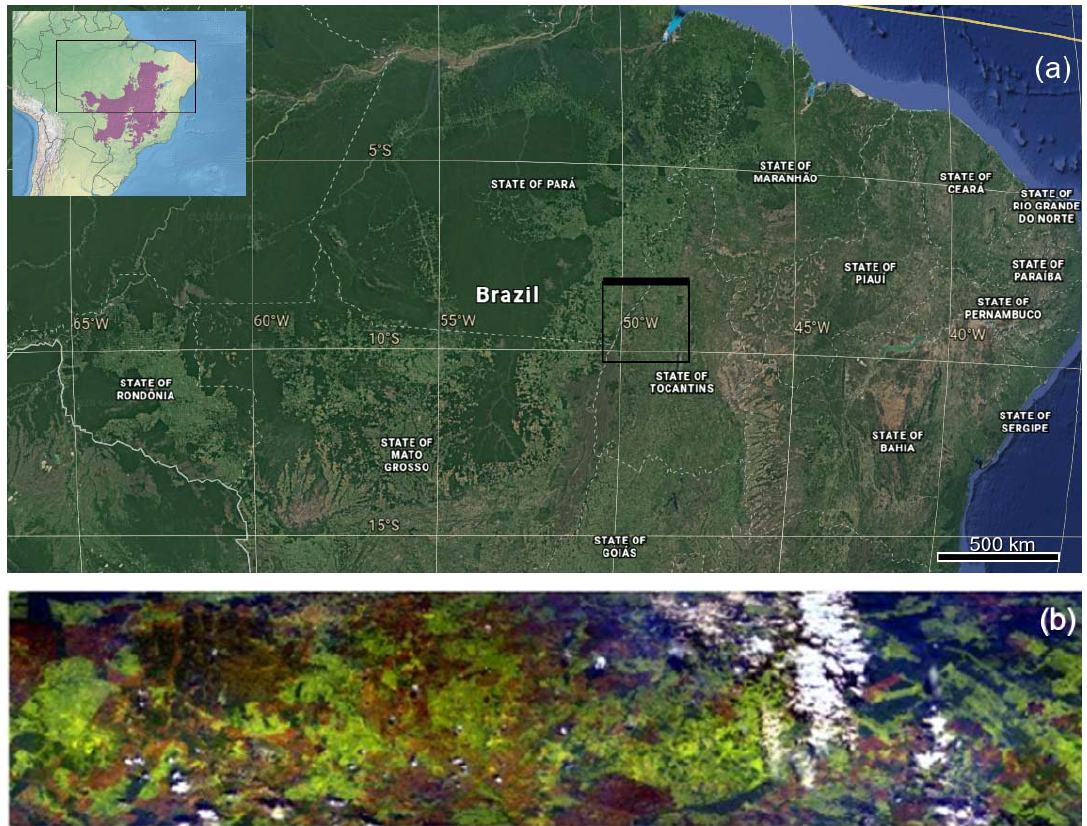
Figure 1. Study region in the Brazilian cerrado. ( a ) The upper left inset shows the distribution of the cerrado landscape in pink, with black rectangle outlining the location of the main figure. The main figure shows a Google Earth image superimposed upon which is the coverage of the 11 September 1995 MODIS Airborne Simulator (MAS) data collection made from a high-altitude NASA ER-2 [2]. Six full flights around a square flight pattern were conducted over five hours, shown by the four-sided flightline black box. The northernmost flight leg, which contained the vast majority of fires and provided the dataset used herein, is depicted by the upper box side bolded. ( b ) MAS true colour composite derived from one overflight of a subset of the northern flight leg as indicated by the bold box side in ( a ), with a swath width of 37 km from the 20 km flying height. Evidence of multiple burn scars (darker brown) left by fires is clear.